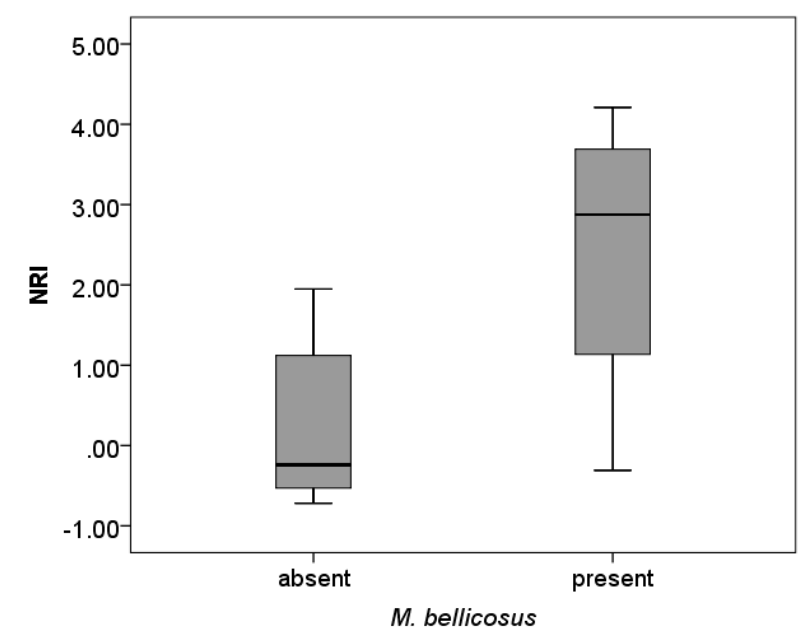
Figure 4. NRI and presence of M. bellicosus . There may be an effect of M. bellicosus on phylogenetic community structure. NRIs were higher (i.e., more phylogenetically clustered communities) when M. bellicosus was present than when it was absent ( p = 0.079).